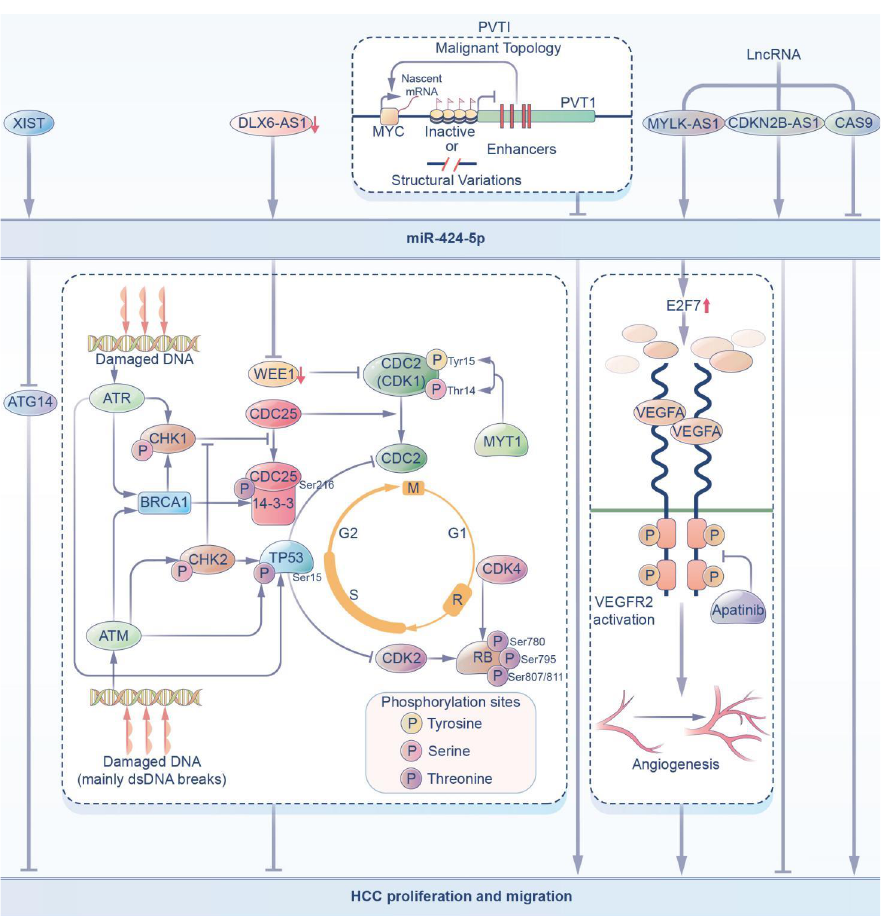
Figure 2. In HCC, miR-424-5p can be regulated by upstream pathways and regulate downstream pathways. (i) XIST can increase the expression of miR-424-5p, which inhibits ATG14, inhibiting HCC proliferation and migration. (ii) The decrease in DLX6-AS1 can target miR-424-5p to inhibit the expression of WEE1, which inhibits HCC proliferation and migration. (iii) PVT1 inhibits the expression of miR-424-5p by regulating the p53 signaling pathway to promote HCC proliferation. (iv) LncRNAs, including MYLK-AS1, CDKN2B-AS1, and CAS9, can affect the expression of miR-424-5p to regulate HCC progression.